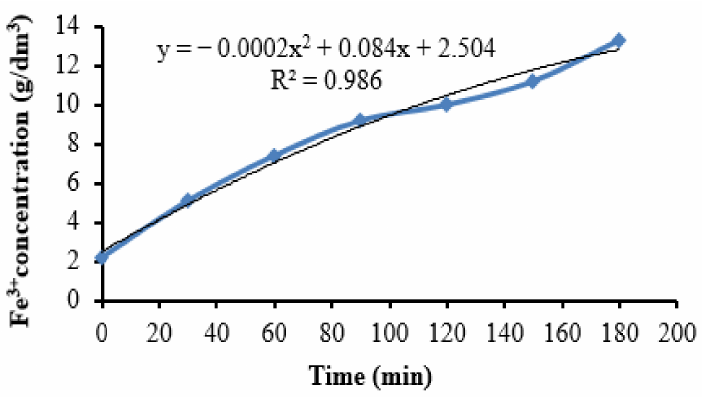
Figure 5. Change in the concentration of Fe(III) during electrooxidation in a flow